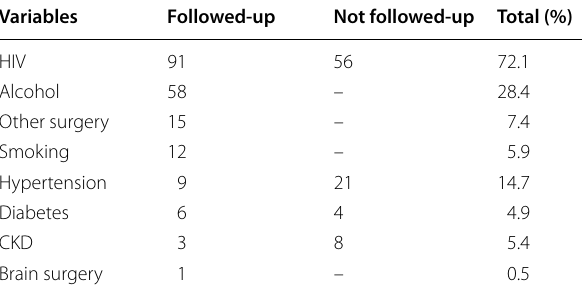
Table 1 Risk factors and comorbidities